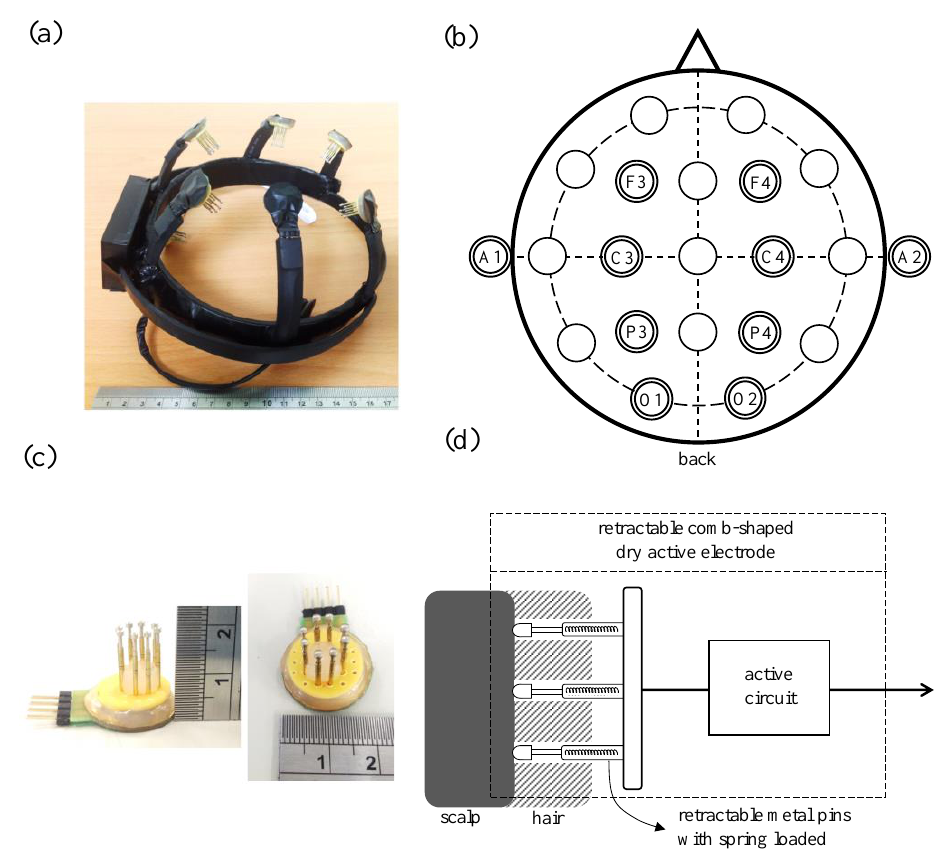
Figure 2. ( a ) Structure of the wearable mechanical design; and ( b ) locations; ( c ) photograph and ( d ) basic scheme of retractable comb-shaped dry active electrodes.